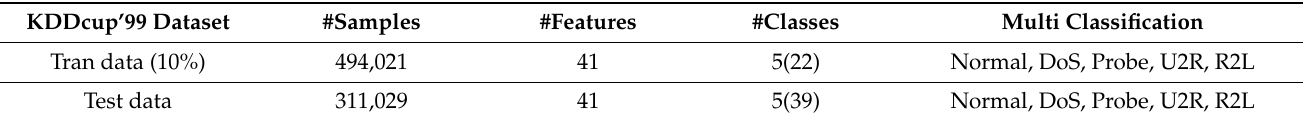
Table 2. Description of KDDcup’99 Dataset.